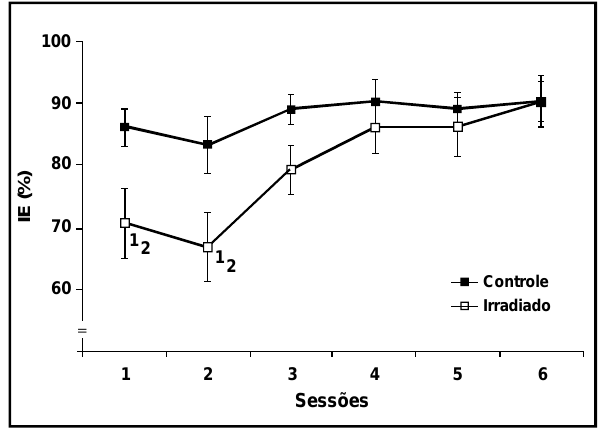
Figura 3. Média (± EP ) dos índices de eficiência ( IE %) dos grupos Controle ( N =9) e Irradiado ( N =9) submetidos ao treino pós- irradiação da tarefa espacial NMTP. Notas. (1) diferença significativa em relação ao grupo Controle, na respectiva sessão; (2) diferença significativa em relação à 6 a . sessão de treino. Teste de Newman-Keuls, p<